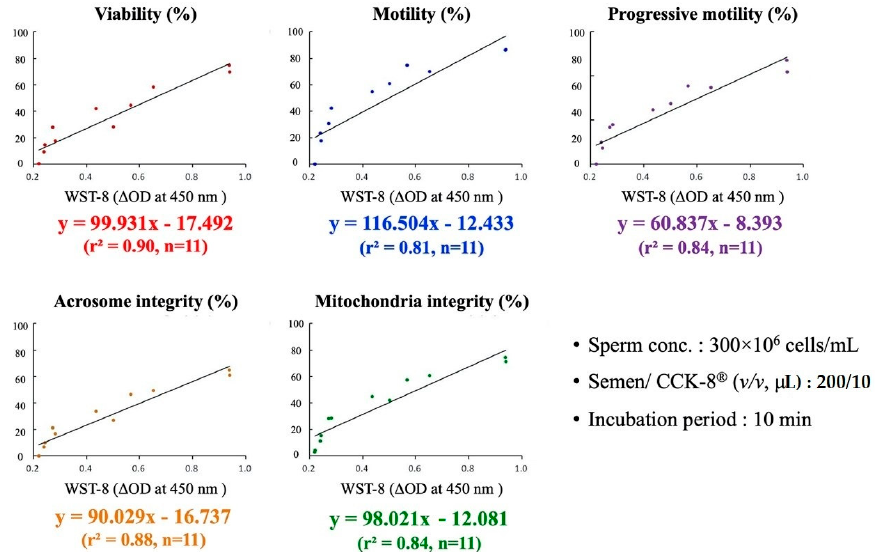
Figure 1. Linear regression and prediction models for sperm concentration of 300 × 10 6 cells / mL. Prediction model and formula between the WST-8 reduction rate ( ∆ OD) and boar sperm viability (%), sperm motility (%), progressive sperm (%), acrosome integrity (%) and mitochondrial integrity (%), at a sperm concentration of 300 × 10 6 cells / mL after 10 min incubation at 37 ◦ C with a semen / CCK-8 ® ratio of 200 / 10.